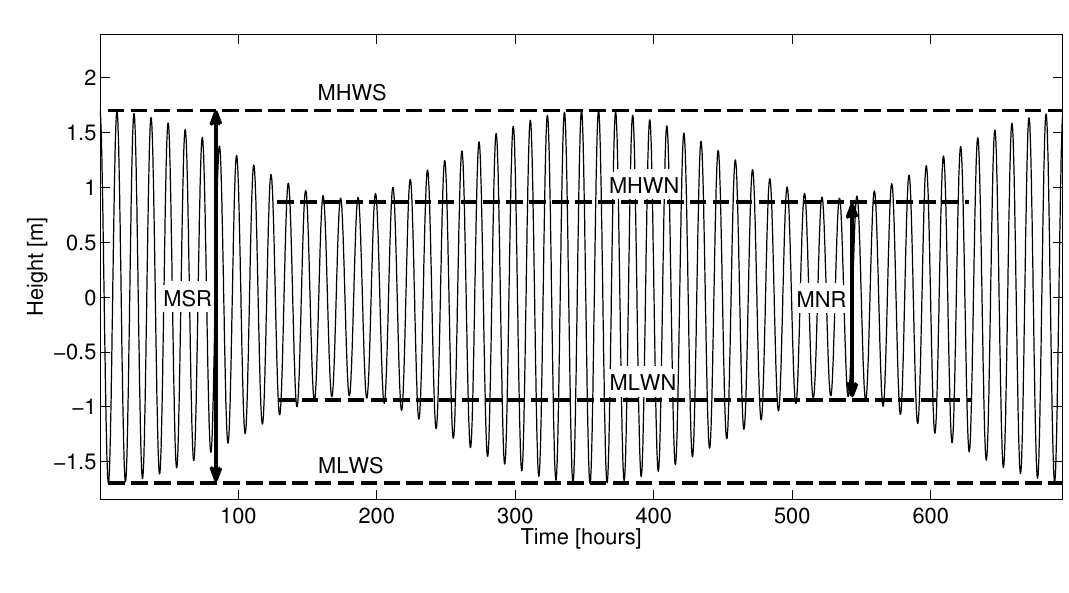
Figure 2. Water height definitions.